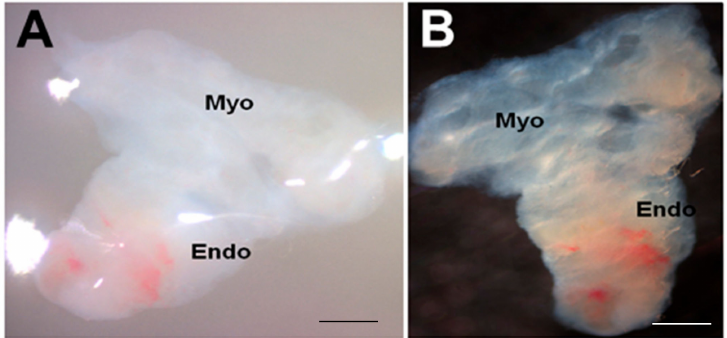
Figure 2. Appearance of endometrial tissue slices after 21 days in culture. ( A ) a tissue slice photographed within the gel; ( B ) the same tissue slice washed in PBS before further processing. Myo, myometrium; Endo, endometrium. Scale bar = 1